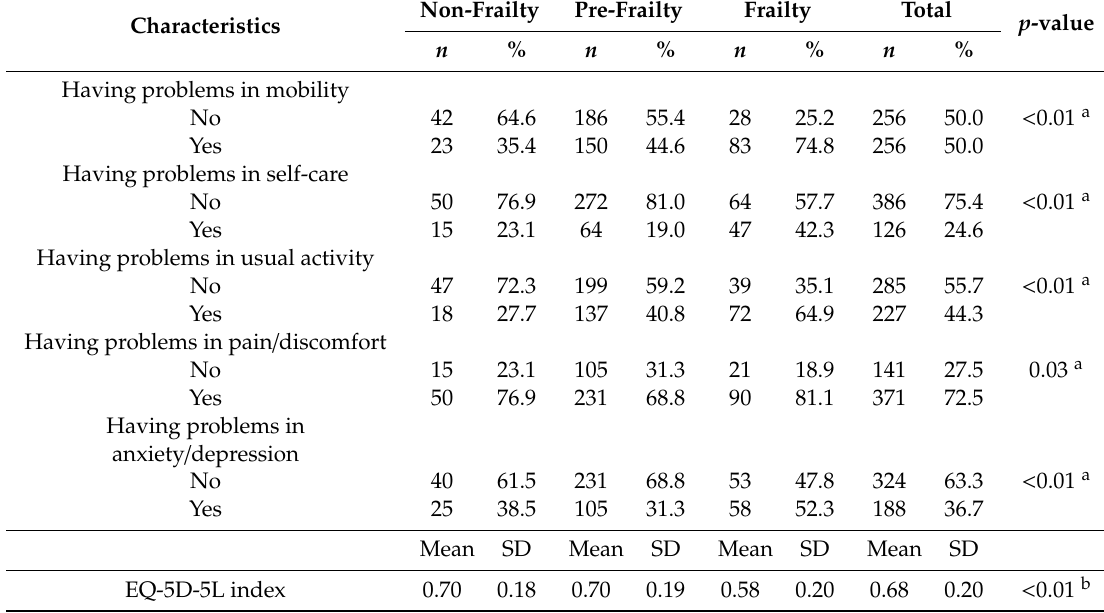
Table 4. Percentage of patients having problems in each domain of EuroQol-5 Dimensions-5 Levels(EQ-5D-5L)according to frailty status. Non-Frailty Characteristics